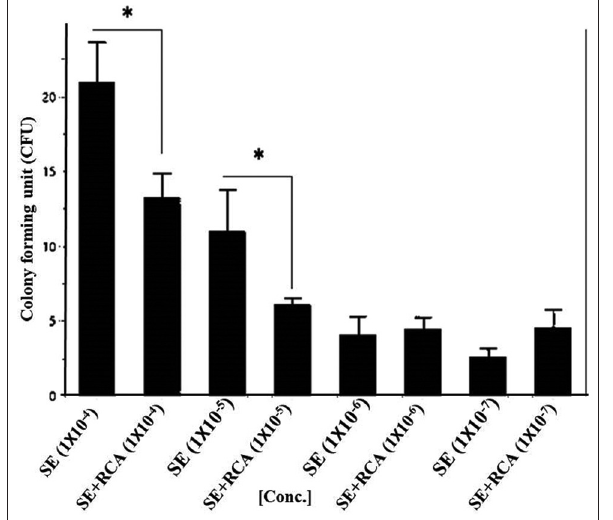
Figure-3: Salmonella Enteritidis (SE) on Luria-Bertani (LB) agar. The bacterial isolate in broth was 10-fold serially diluted and mixed with a constant concentration of anti- Salmonella DNA aptamers in the form of rolling circle amplification. The colony-forming unit on the LB agar was calculated and blotted with a concentration of the rolling circle amplification (RCA) products. The RCA products showed a significant ability to reduce the growth of the bacteria (p<0.001) in the higher bacterial concentrations, that is, 1×10 –4 and 1×10 –5